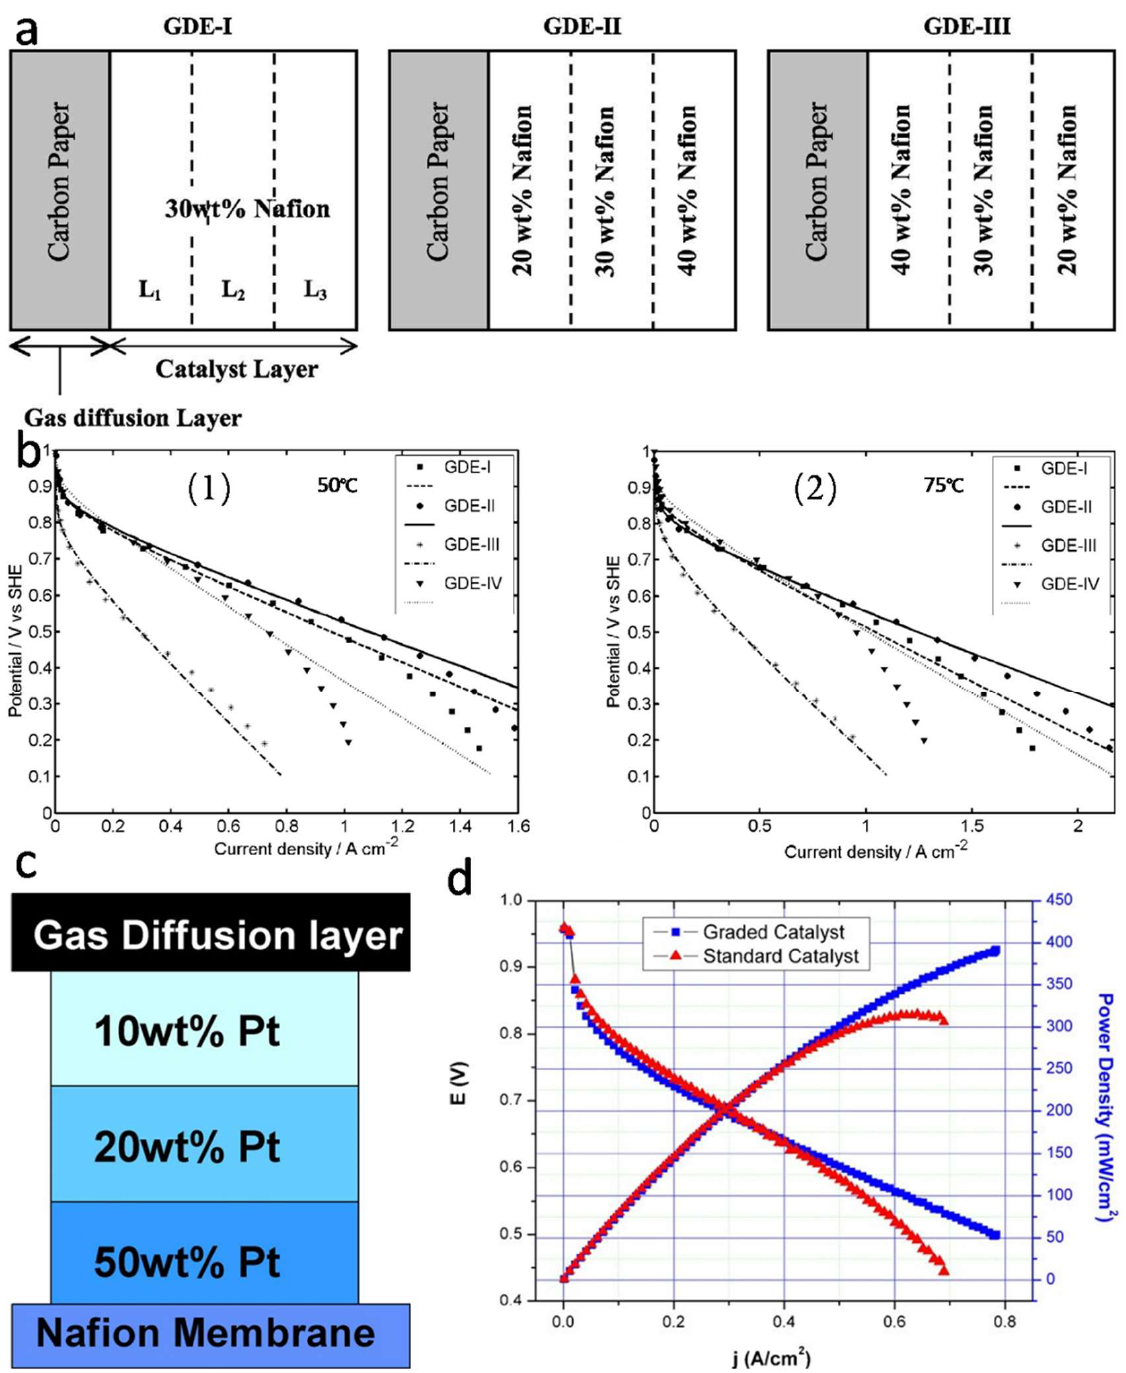
Figure 10. ( a ) Schematic of gas diffusion electrodes (GDEs) based on CLs with uniform and graded contents of Nafion; ( b ) Effects of the Nafion distribution in cathode on polarization plots: ( b1 ) 50 ◦ C, ( b2 ) 75 ◦ C. Reproduced from Ref. [164] with permission from The Electrochemical Society, copyright 2005. ( c ) Schematic diagram of grade-structured catalyst layers; ( d ) Performance comparison between graded catalyst and standard uniform catalyst. Reproduced from Ref. [165] with permission from Elsevier, copyright